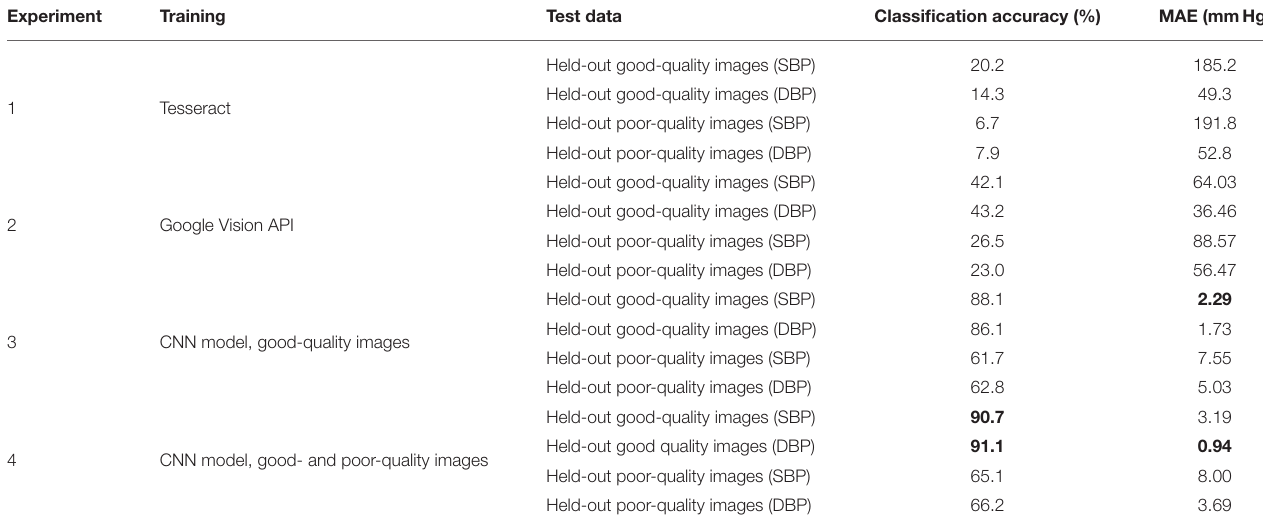
TABLE 1 | Optical character recognition (OCR) performance. Experiment